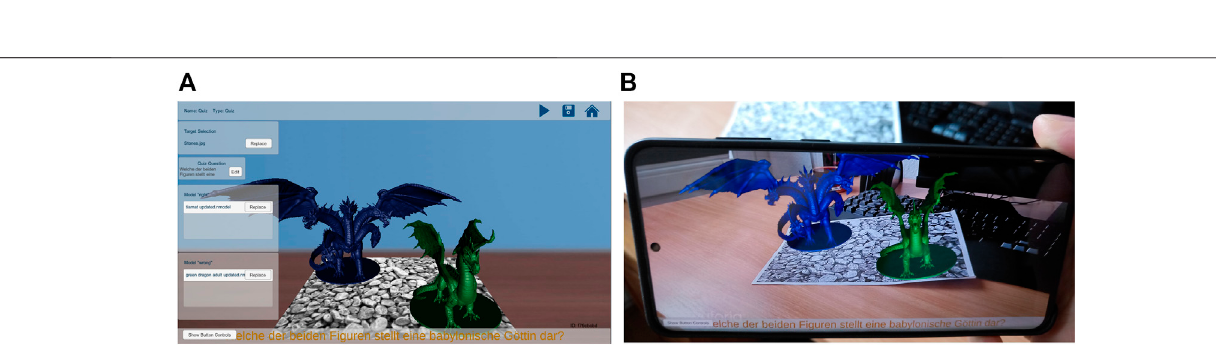
Frontiers in Virtual Reality |